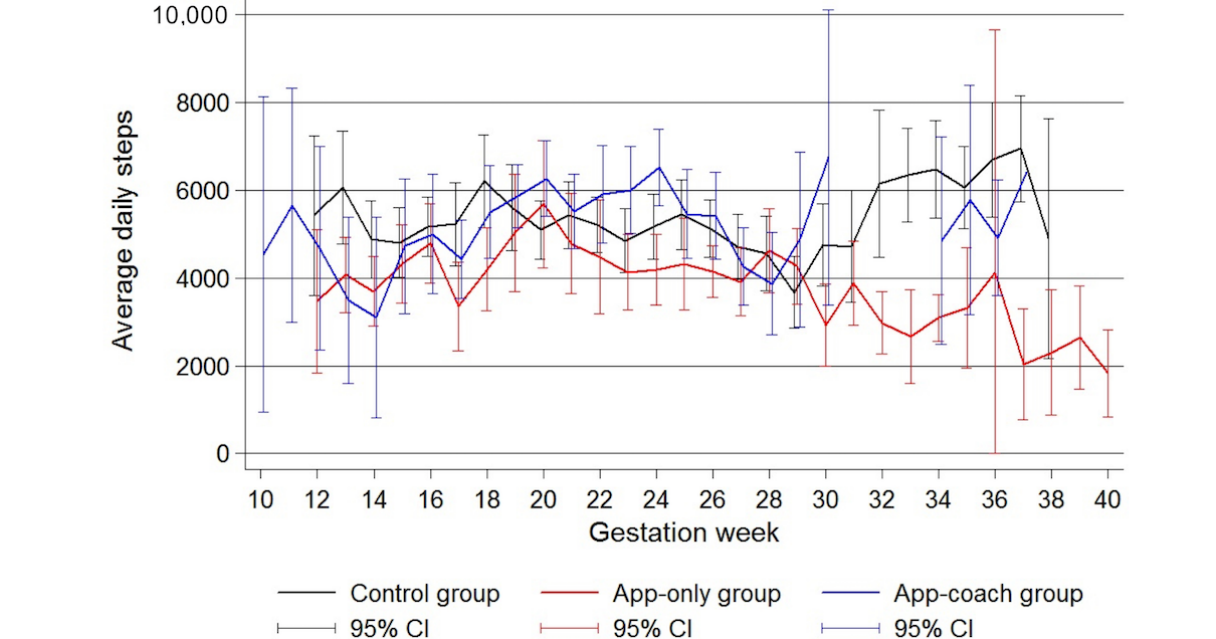
Figure 3. Line plot showing the average (mean) daily steps by gestation week and treatment group for the 27 patients who completed the study with the corresponding 95% CI. Note missing step data in the app-coach group between 30 and 34 weeks.